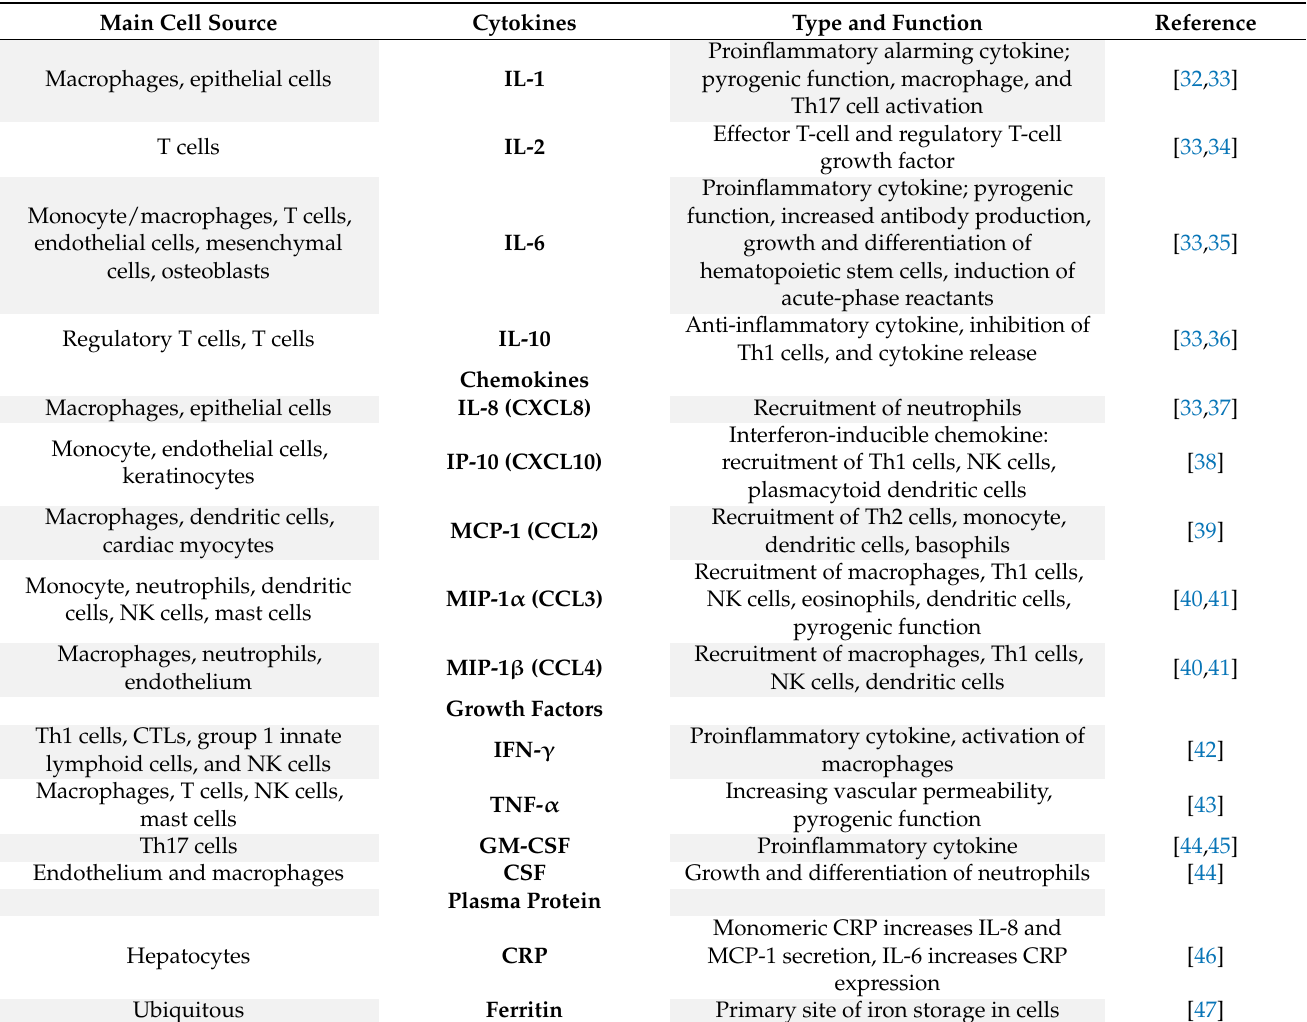
Table 2. Soluble mediators over-expressed in cytokine release